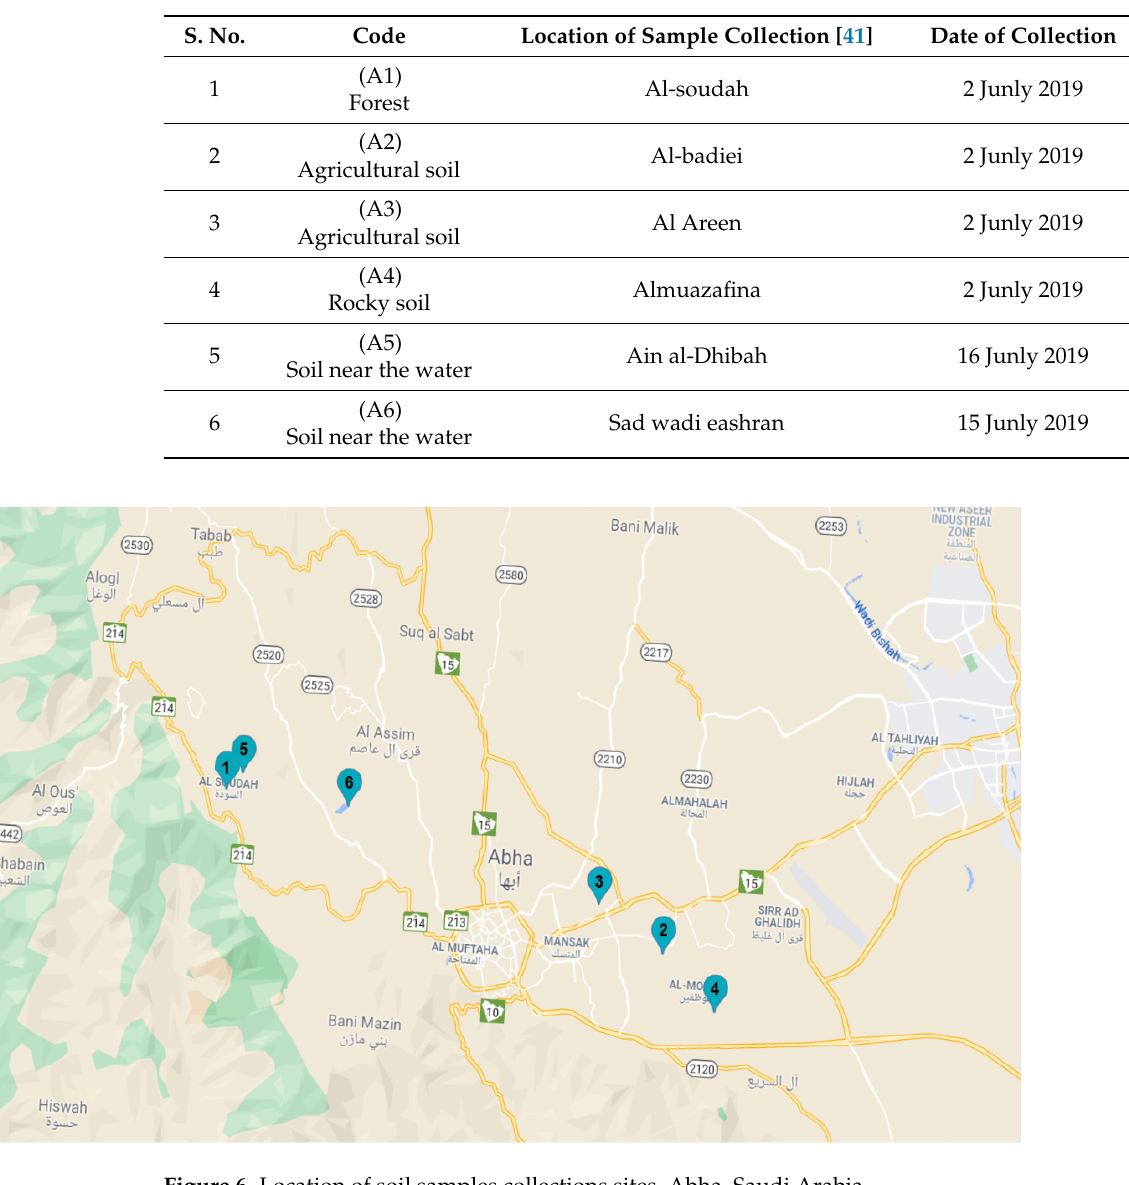
Table 6. The location of soil sample collections sites, Abha, Saudi Arabia.